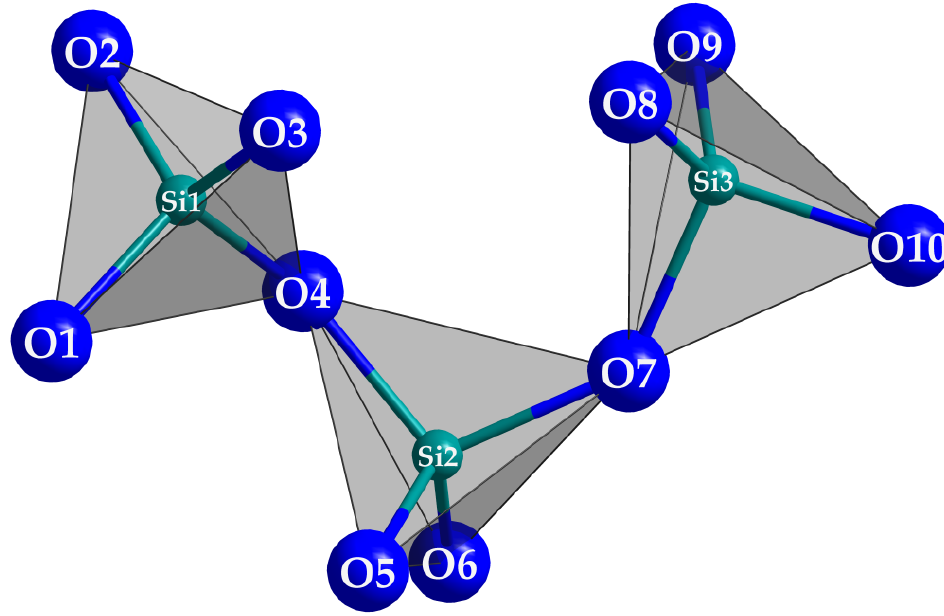
Table 4. Motifs of mutual adjunction [23,24] for the Tm 3 F[Si 3 O 10 ] structure.